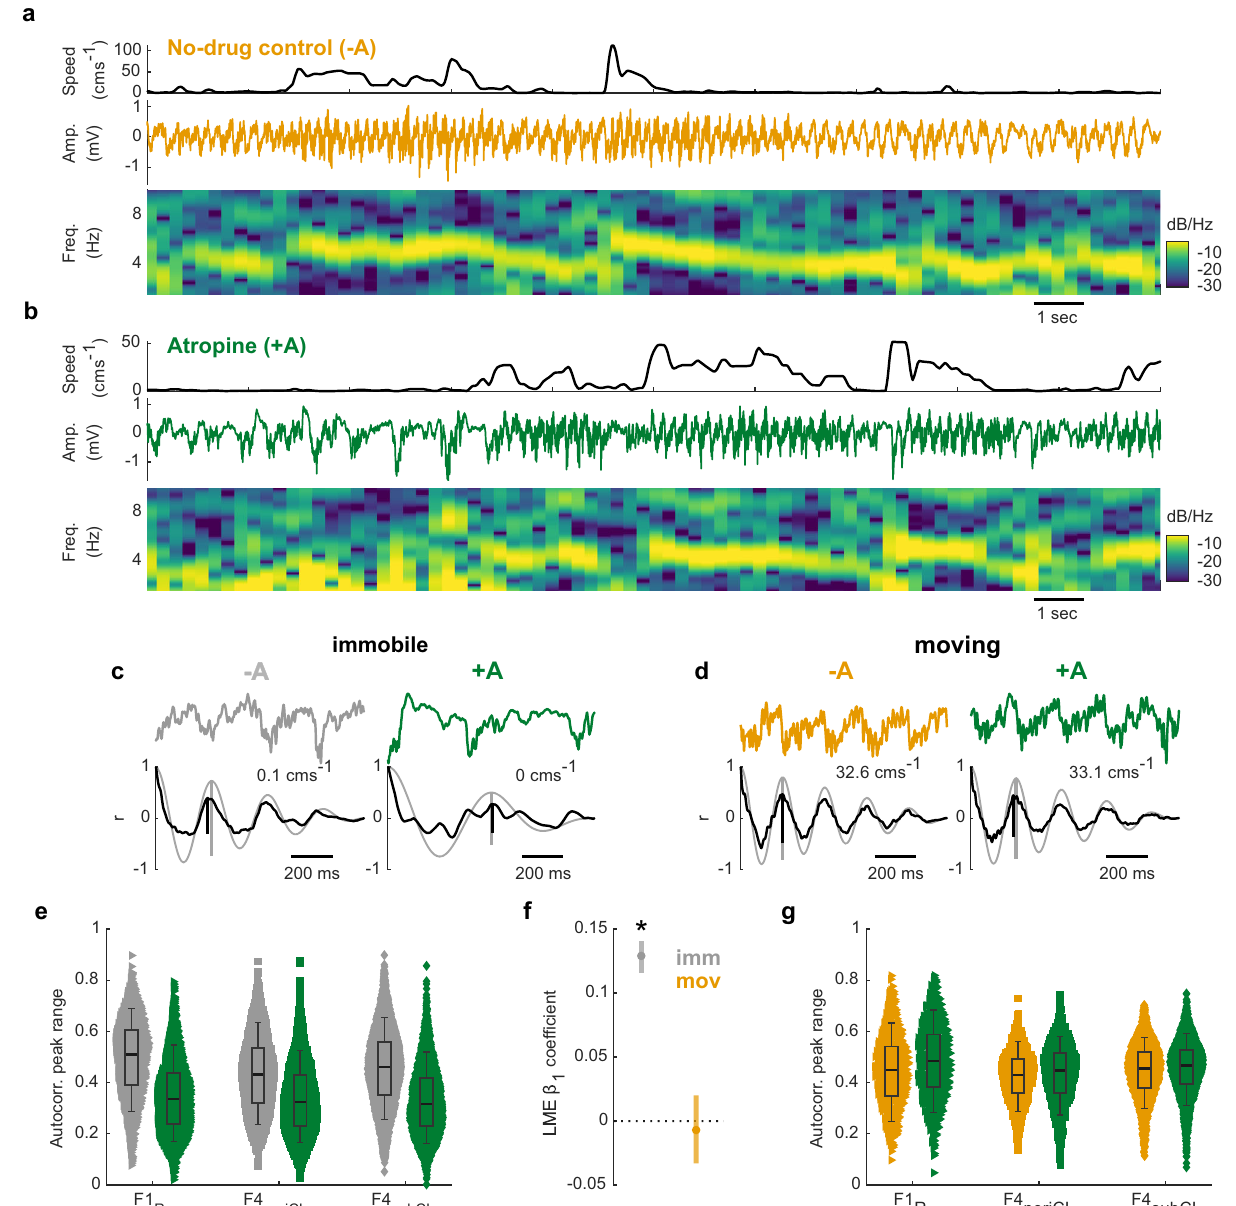
Fig. 5 | Immobility-related oscillatory activity in the ferret is abolished by